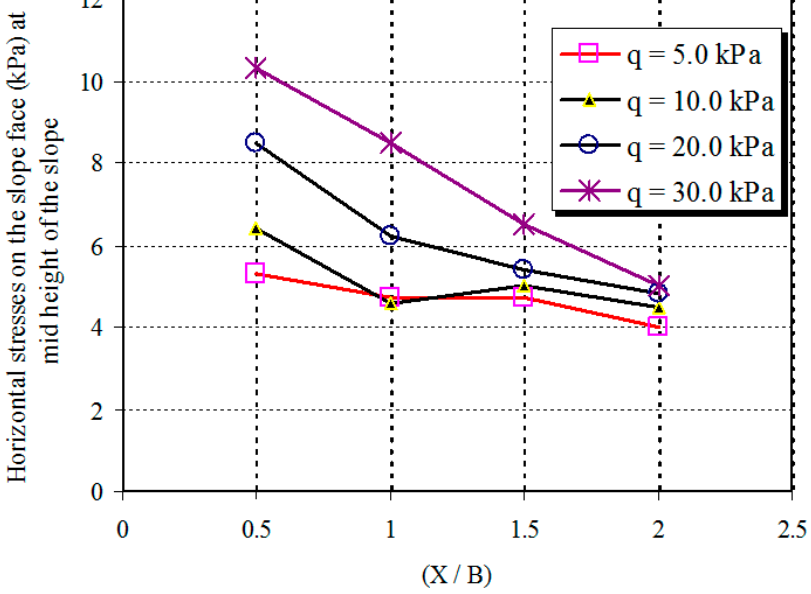
Figure 29. Influence of footing position on the slope face horizontal stresses under the nails at mid- height of slope. mid-height of